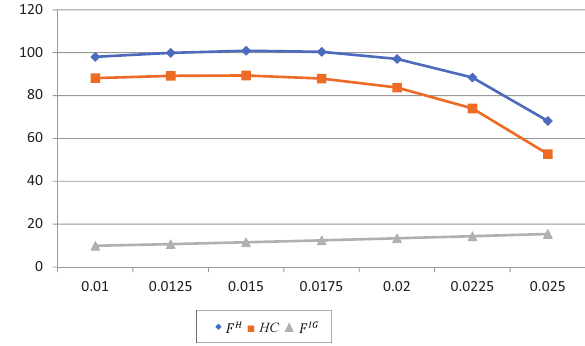
Figure 3. Housing value composition and utility rental benefit rate